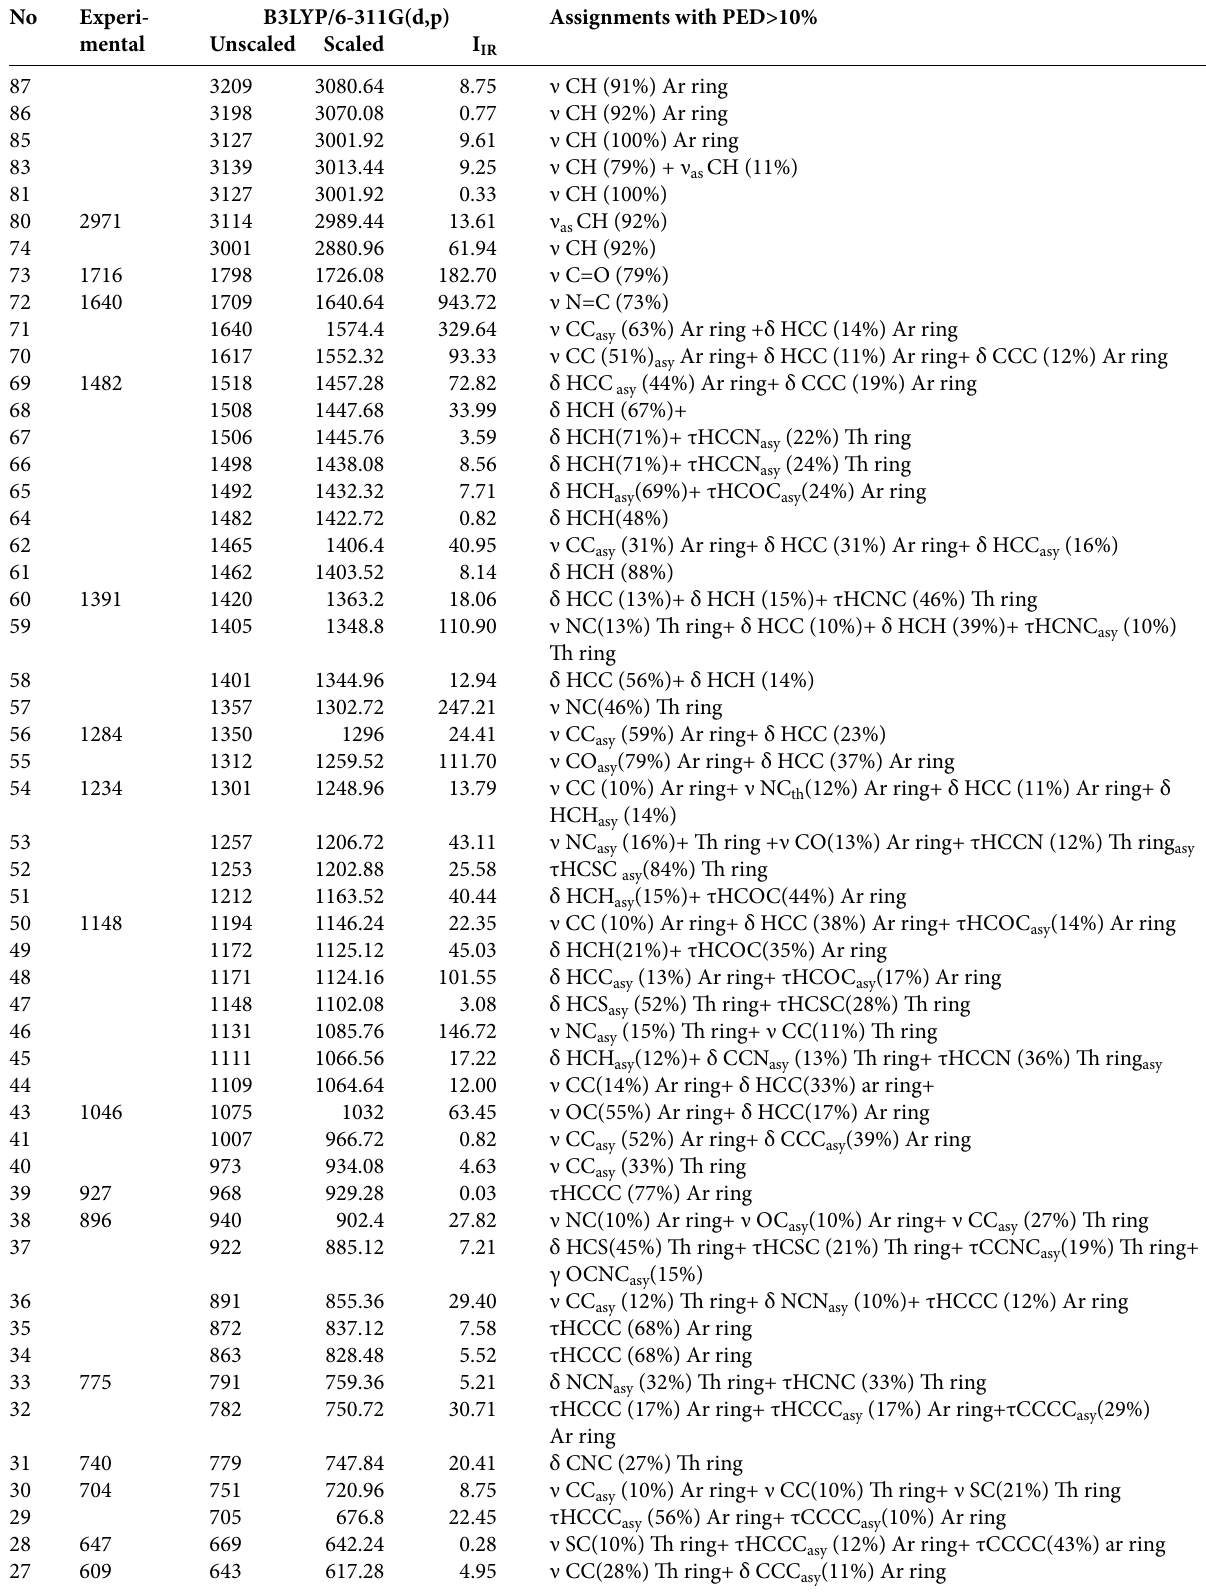
Table 6. Comparison of the calculated harmonic frequencies using B3LYP method 6-311G(d,p) basis set and experimental (FT-IR) wavenumbers (cm –1 ) for ( Z )-3- N -(ethyl)-2- N